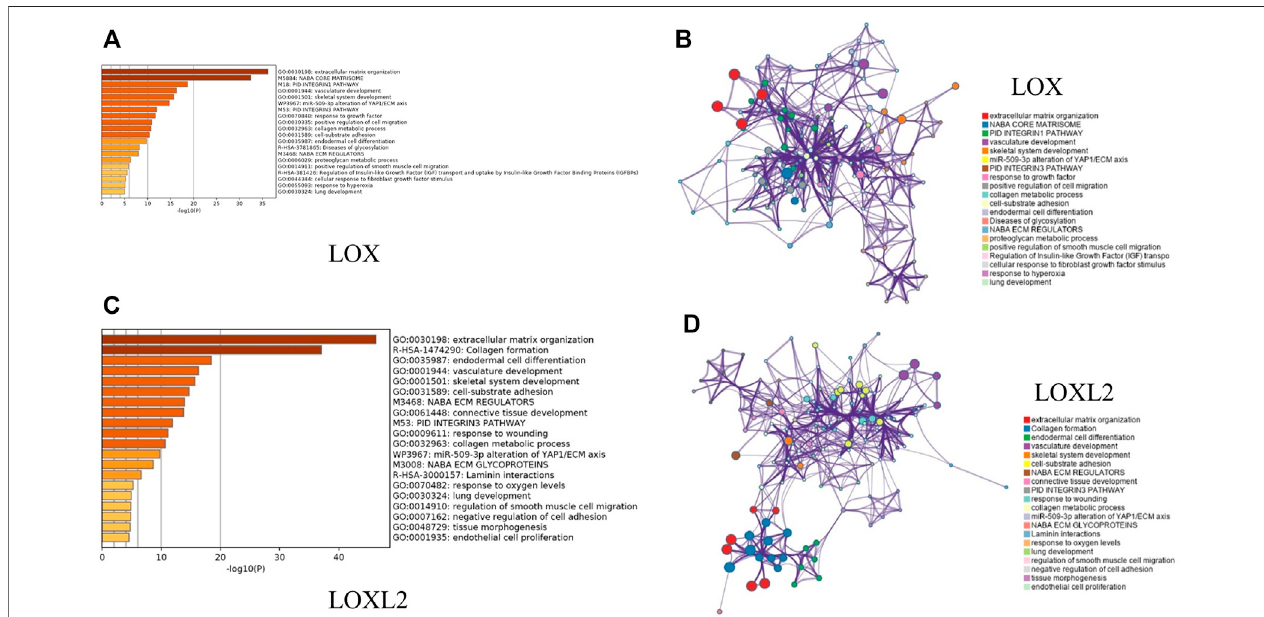
FIGURE 6 | Functional enrichment analysis of genes co-expressed with LOX and LOXL2 using Metascape. (A , C) Heatmaps of the molecular functions, biological processes,orpathwaysenrichedwithLOXandLOXL2co-expressedgenes.Thebarcolorshadewasdecidedbythe p value,thedeepertheshade,thelessthe p value. (B , D) Networks exhibiting interactions among the clusters of genes enriched in the molecular functions, biological processes, or pathways presented in the heatmaps. The points in different colors represented clusters of genes enriched in different molecular functions, biological processes, and pathways.